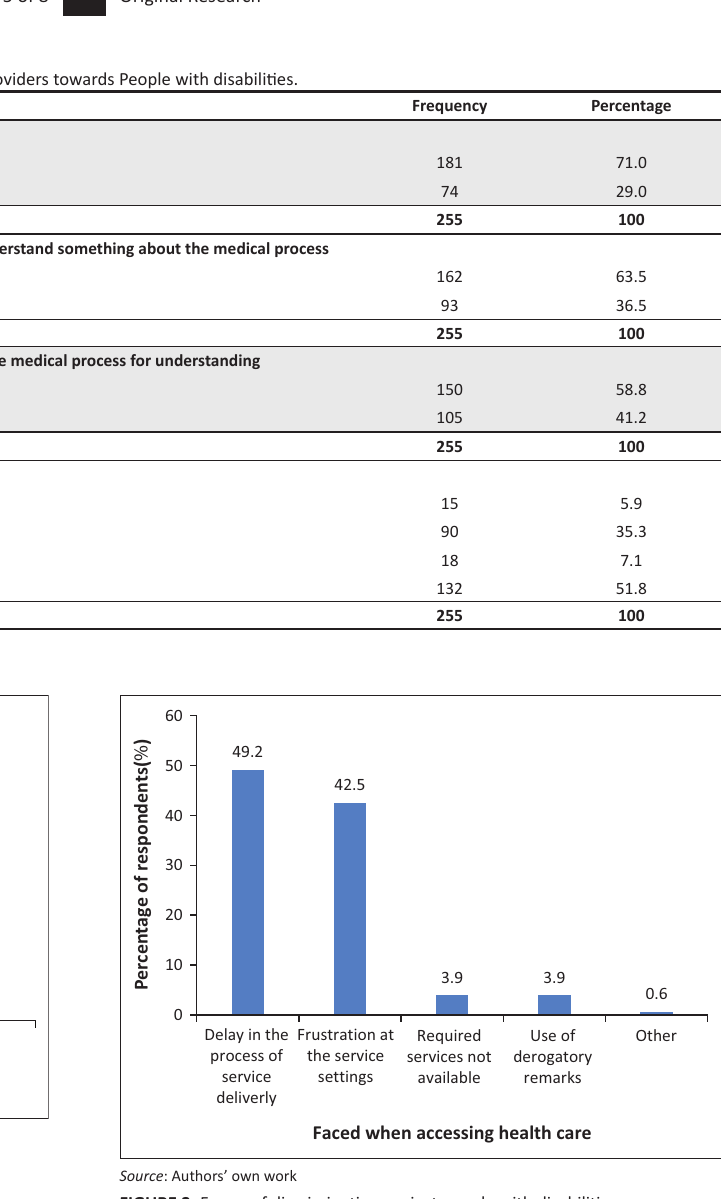
FIGURE 2: Forms of discrimination against people with